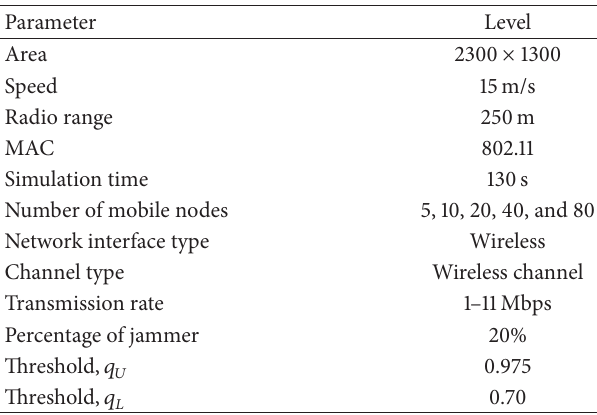
Table 1: Parameters for